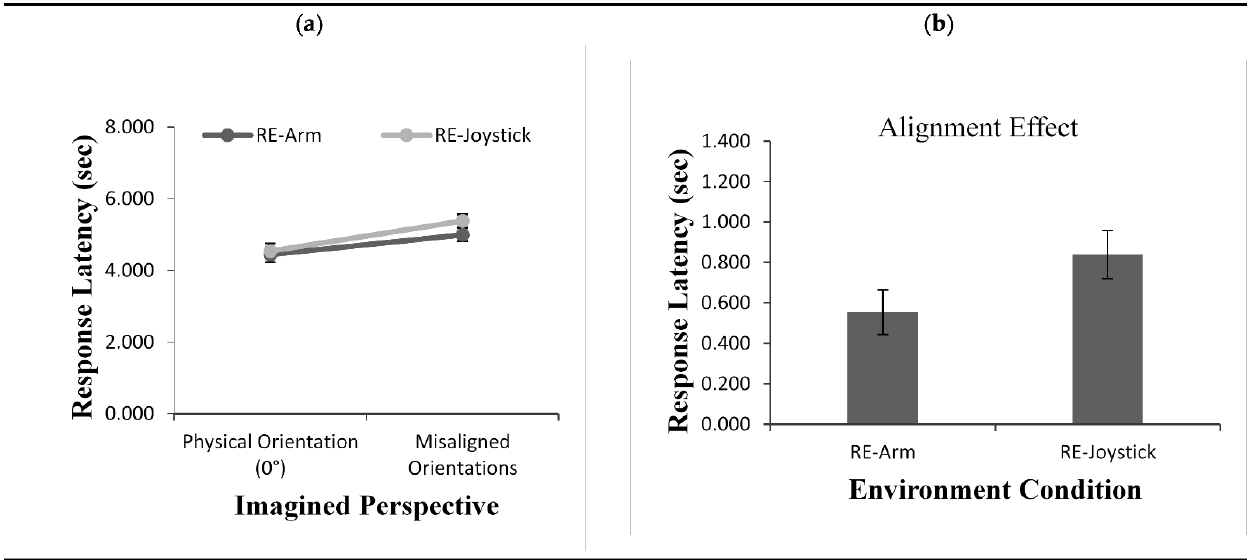
Figure 9. Response latency ( a ) as a function of imagined perspective and alignment effect for response latency ( b ) across test conditions (RE-Arm vs. RE-Joystick) in Experiment 2 and Experiment 3. Error bars represent standard errors from the ANOVA and from a t -test, respectively.